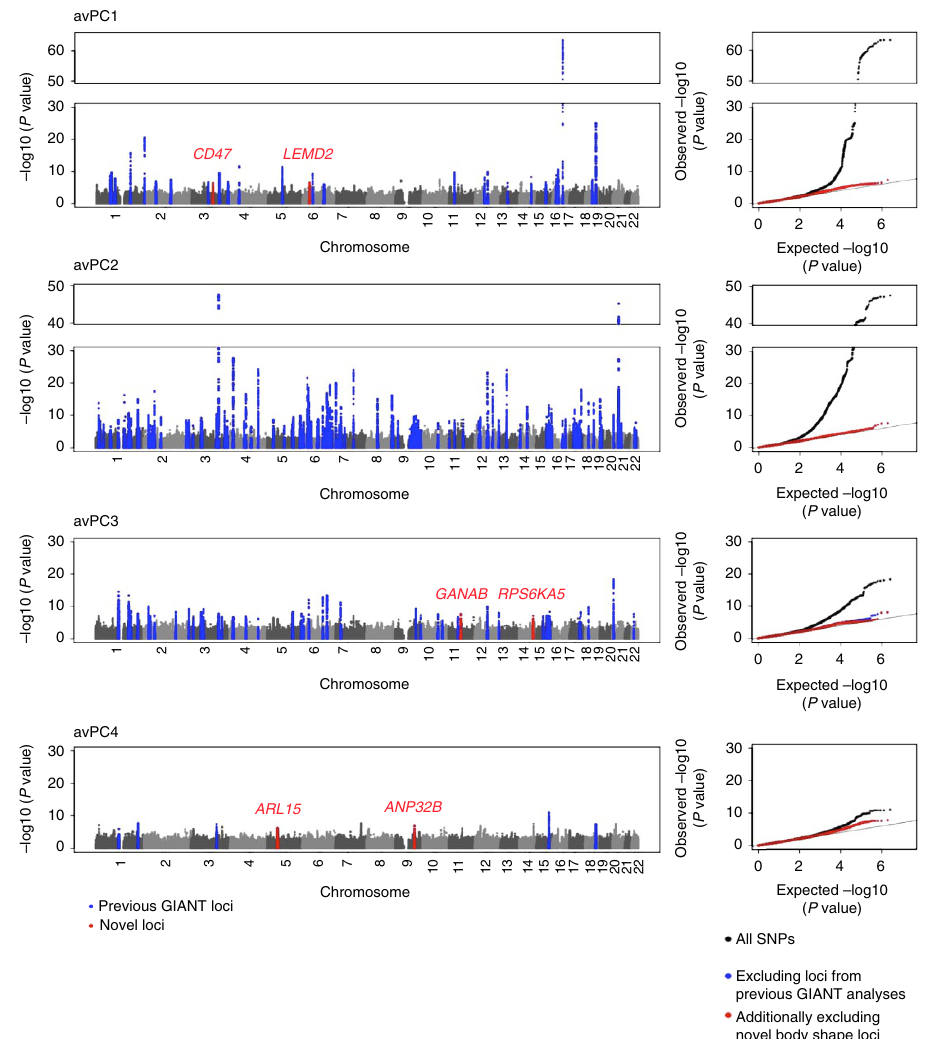
Figure 2 | Manhattan and QQ-plots of association results on AvPCs of body shape. P values of the first stage meta-analysis are given in the Manhattan and QQ-plots. All genome-wide significant loci are